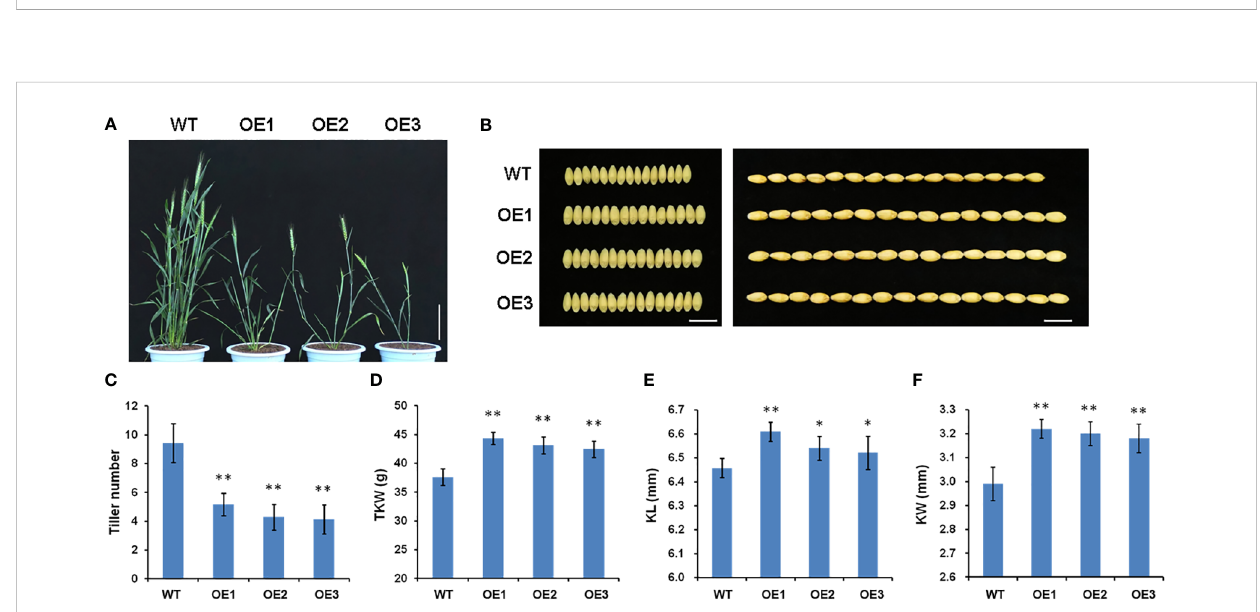
FIGURE 3 Phenotypic comparison of wild-type (WT) and three TaSPL14-7A overexpression (OE) lines. (A) Comparison of the plant architecture phenotype at heading stage among these genotypes. Bar = 20 cm. (B) Comparison of the kernel phenotypes among these genotypes. Bar = 1cm. (C) Tiller number; (D) Thousand kernel number (TKW); (E) Kernel length (KL); (F) Kernel width (KW). The values are presented as mean ± SD. ** P <0.01; * P <0.05 (Student ’ s t